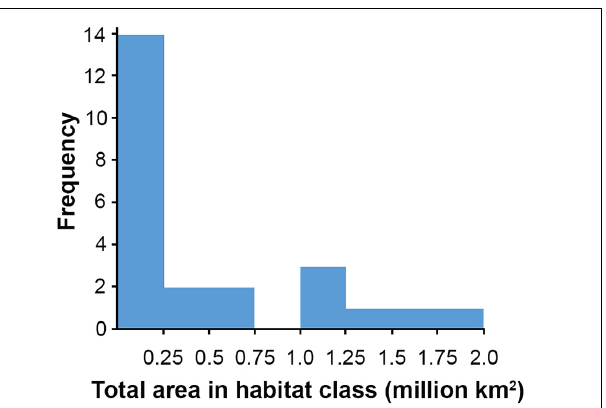
FIGURE 6 | Number of habitat classes of different total areas.